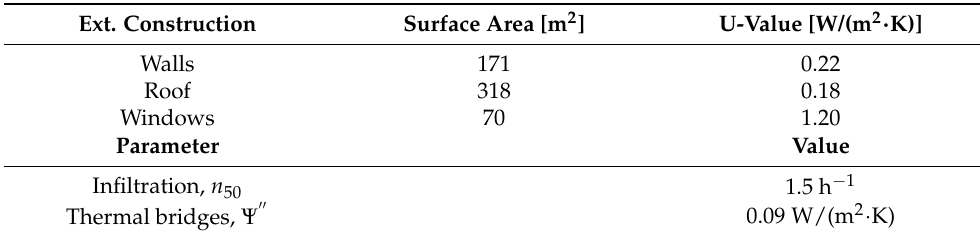
Table 3. Thermal properties of the building envelope.